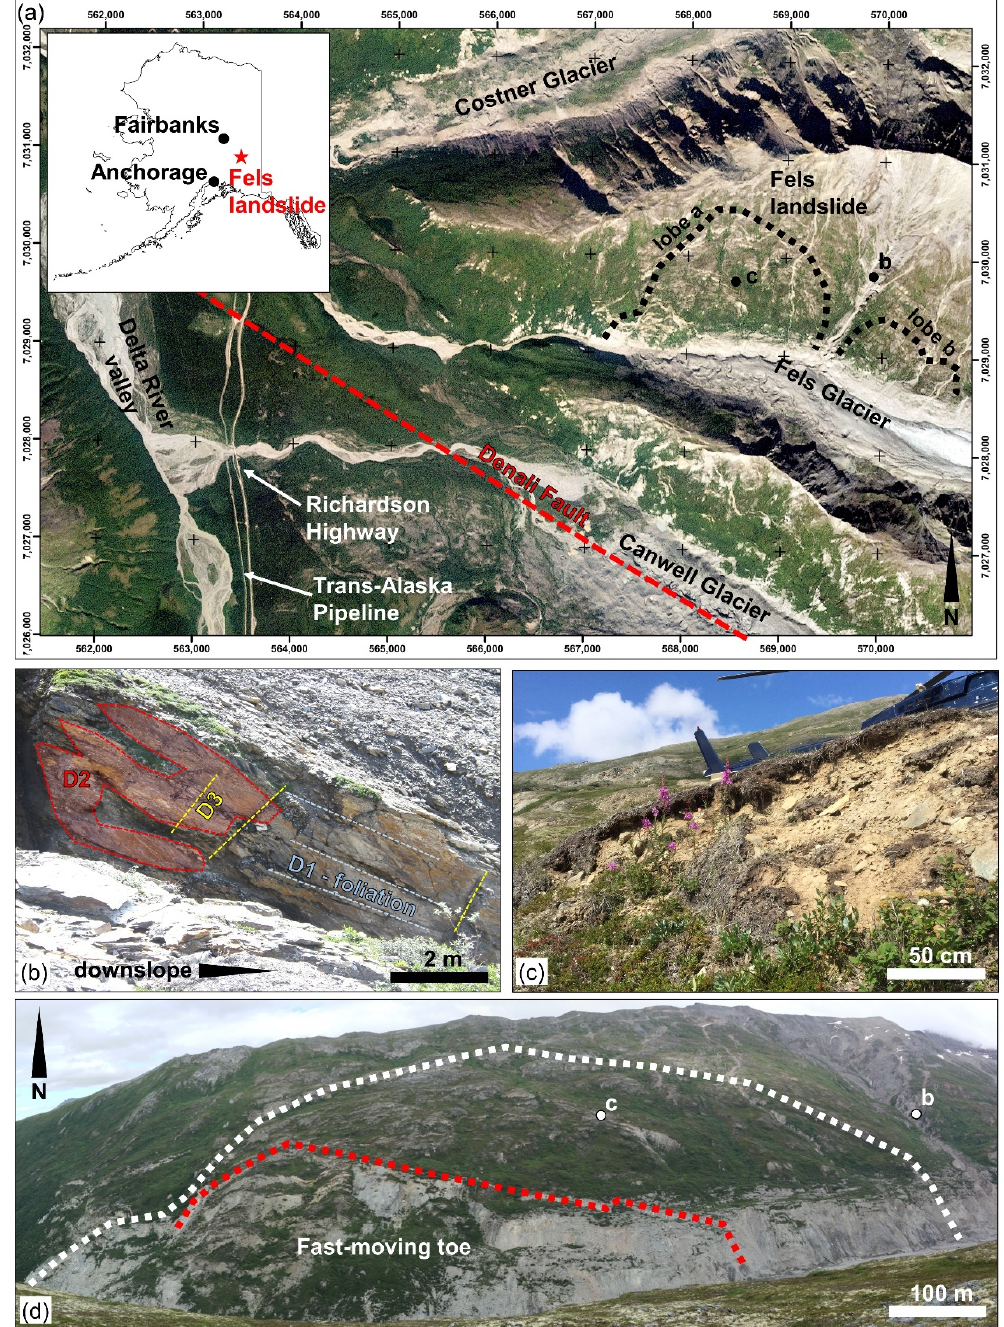
Figure 1. Overview of Fels landslide. ( a ) 2017 satellite view of the intersection of the Delta River and Fels valleys (RapidEye 4, WGS84/UTM 6N grid). The dotted lines delineate the areas of ongoing slope deformation within Fels Glacier valley, lobe a and lobe b. Fels landslide (lobe a) is located near the terminus of Fels Glacier. The red dashed line shows the trace of the Denali Fault. ( b ) Detail of the rock mass forming the slope. Note the slope-parallel foliation and the discontinuity sets: D2, which forms the outcrop surface (red, dashed outline shows a D2 discontinuity plane), and D3, dipping into the slope. ( c ) View of a surface slump scar, displaying the colluvial material draping the slope. ( d ) Frontal view of Fels landslide as seen from the southern slope of Fels Glacier valley. The white, dotted line outlines the inferred surface area of the landslide. The red, dotted line outlines the boundary of the fast-moving toe. The white labeled dots in ( a ) and ( d ) show the locations where, respectively, photos in ( b ) and ( c ) were taken.